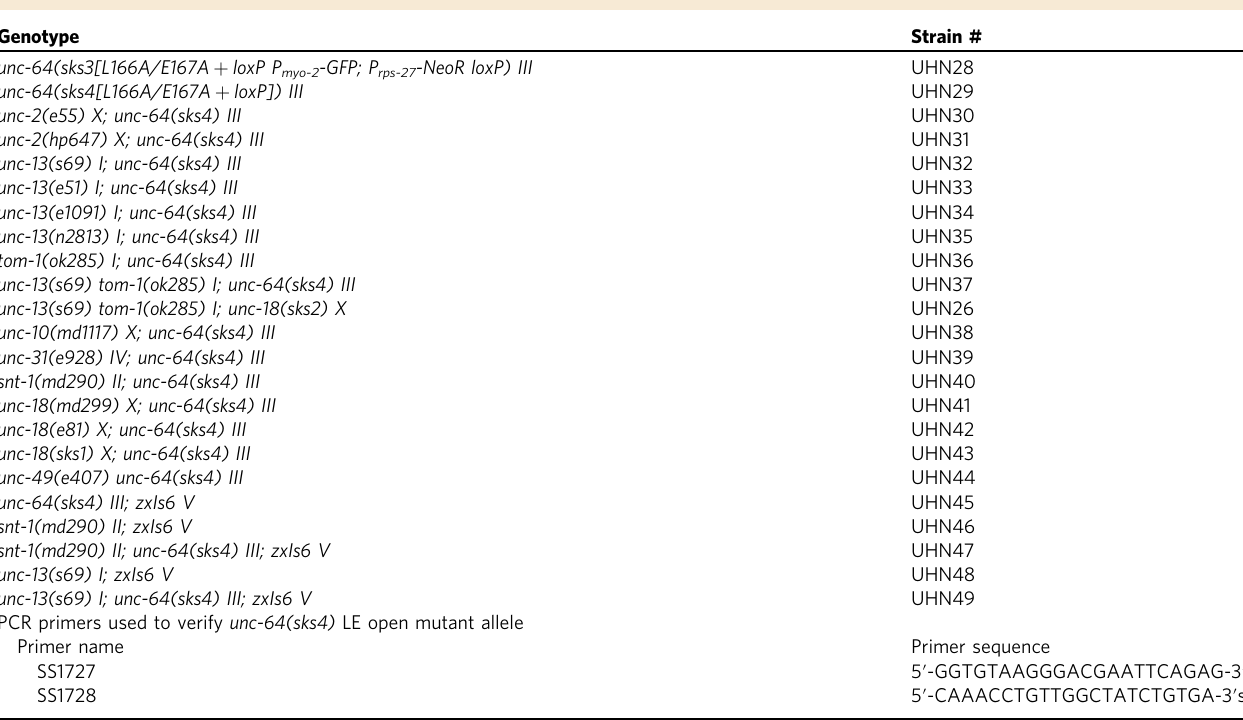
Table 1 C. elegans knock-in mutants, alleles, and